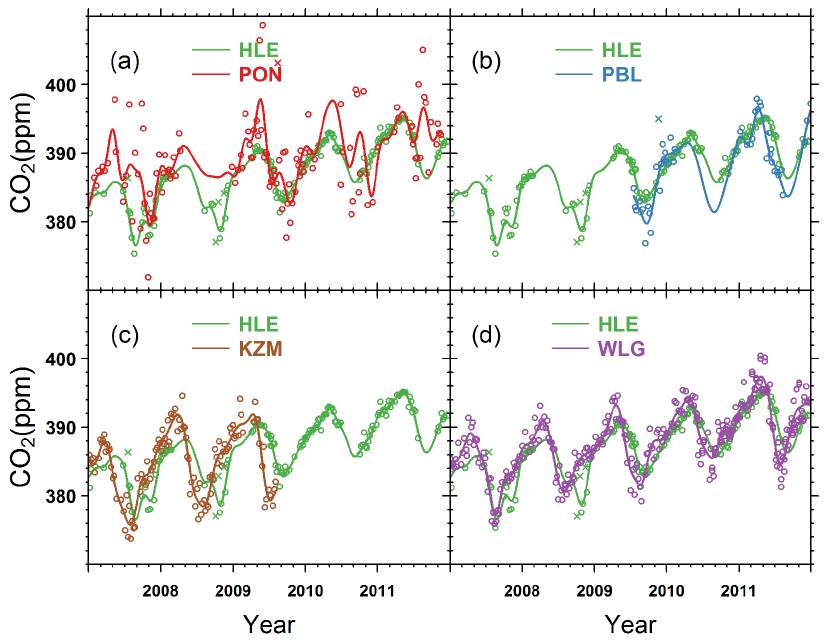
Figure 2. Time series of CO 2 flask measurements at (a) HLE and PON, (b) HLE and PBL, (c) HLE and KZM, and (d) HLE and WLG. The open circles denote flask data used to fit the smoothed curves, while the crosses denote discarded flask data lying outside 3 times the residual standard deviations from the smoothed curve fits. For each station, the smoothed curve is fitted using Thoning’s method (Thoning et al., 1989) after removing